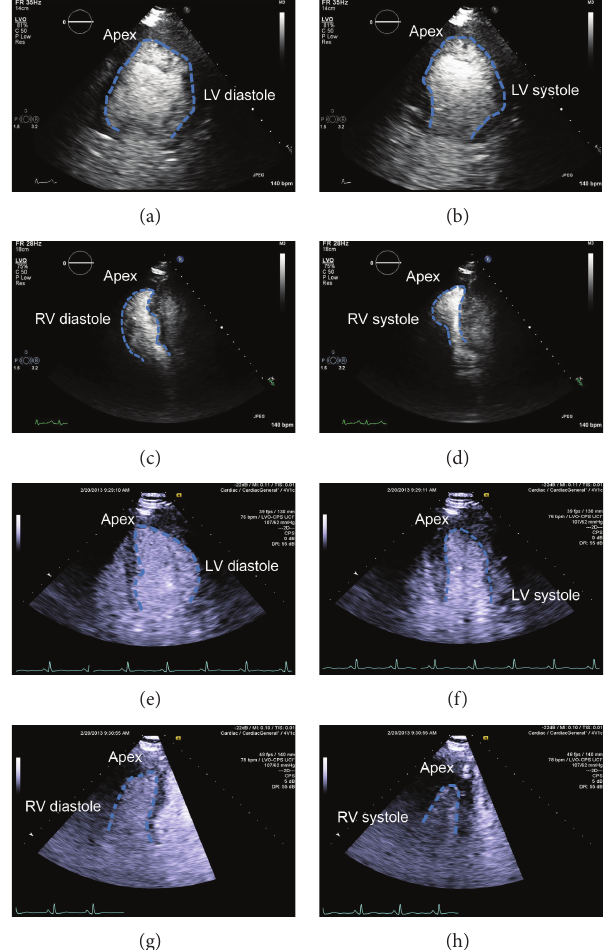
Figure 2: Postpericardiectomy transthoracic echocardiograms illustrating stress cardiomyopathy and recovery. The end diastolic and end systolic ((a) and (b), resp.) left ventricle in apical 2-chamber views and the end diastolic and end systolic ((c) and (d), resp.) right ventricle in apical 4-chamber views illustrating the akinetic apical and midregional wall motion abnormalities and hyperdynamic contractile base of both ventricles, consistent with stress cardiomyopathy, on postoperative day 1. Postdischarge echocardiography 7 weeks later shows normalized wall motion and function of the left ((e) and (f)) and right ventricles ((g) and (h)) in end diastole and end systole, respectively. The endocardial border is outlined in blue dashed line. The apex of the left and right ventricles is oriented to the top of each panel as